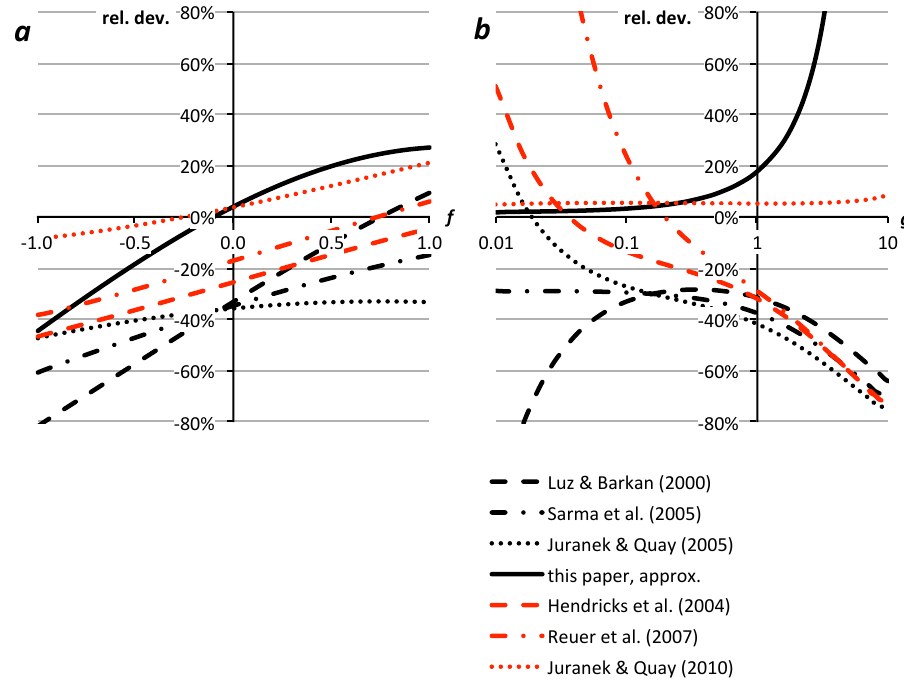
Fig. 3. Relative deviation of g from the base case for different calculation methods (see Table 3). Panel (a) corresponds to g = 0 . 4 and a range of f from − 1.0 to +1.0 (negative values correspond to net heterotrophy, positive value to net autotrophy). Panel (b) corresponds to f = 0 . 1 and range of g from 0.01 to 10 (logarithmic axis). Black curves correspond to calculation methods based on Eq. (1). Red curves correspond to iterative